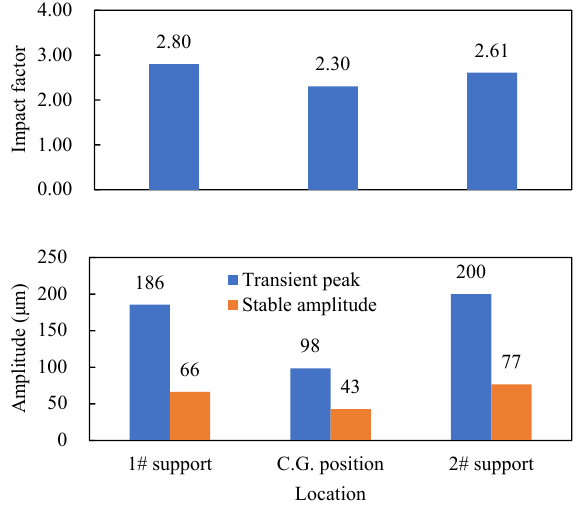
Figure 15. Response and corresponding impact factors at different locations.